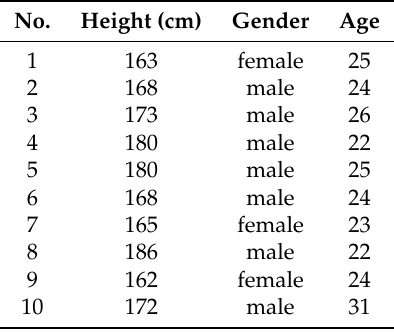
Table 3. The specific information of the